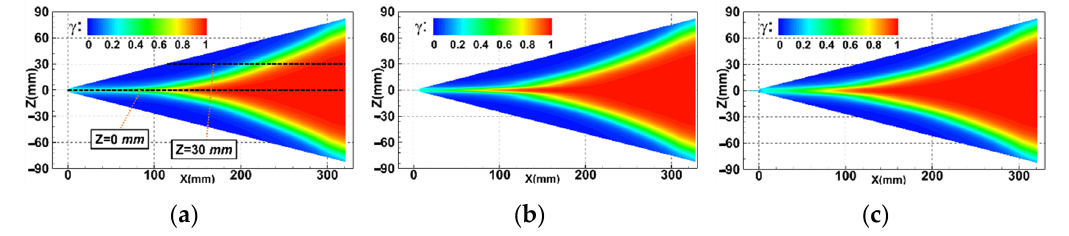
Figure 13. Distributions of γ . ( a ) L = 2 mm, ( b ) L = 6 mm, ( c ) L = 12 mm.